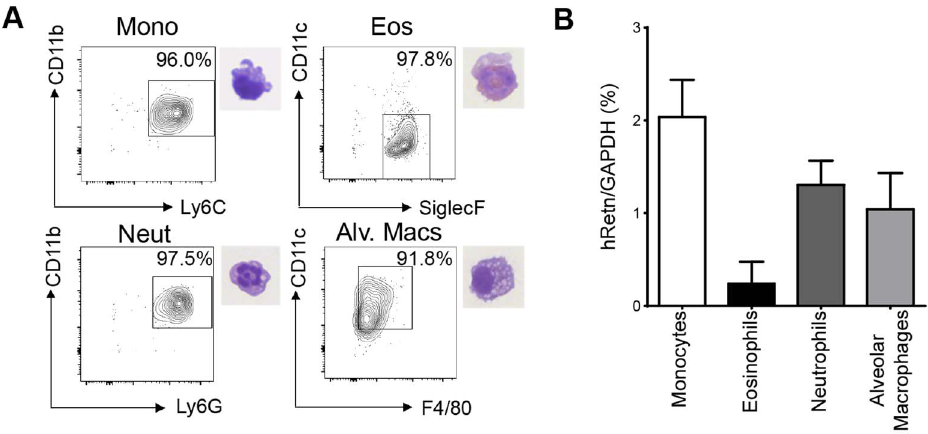
Fig. 2. Monocytes, neutrophils and alveolar macrophages express hResistin in Nb -infected lungs. (A) Gating strategy for sorted lung cells from Nb -infected mice for CD11b + Ly6C + monocytes, SiglecF + CD11c 2 eosinophils, CD11b + Ly6G + neutrophils, and CD11c + F4/80 + alveolar macrophages and corresponding H&E stained cytospins. (B) Sorted cells were recovered for RNA and analyzed for h Retn by real-time PCR. Data (mean 6 SEM, n=3–4 per group) are representative of three separate experiments.